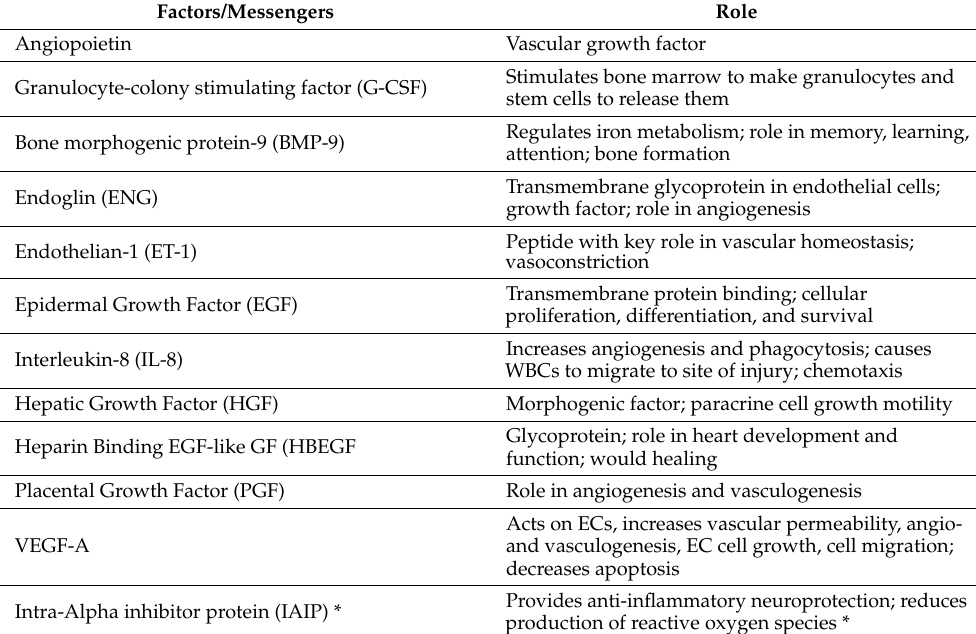
Table 2. Some components in cord blood and their role in the body. WBCs, white blood cells; ECs, endothelial cells. (Adapted from Chaudhury 2019; * Disdier